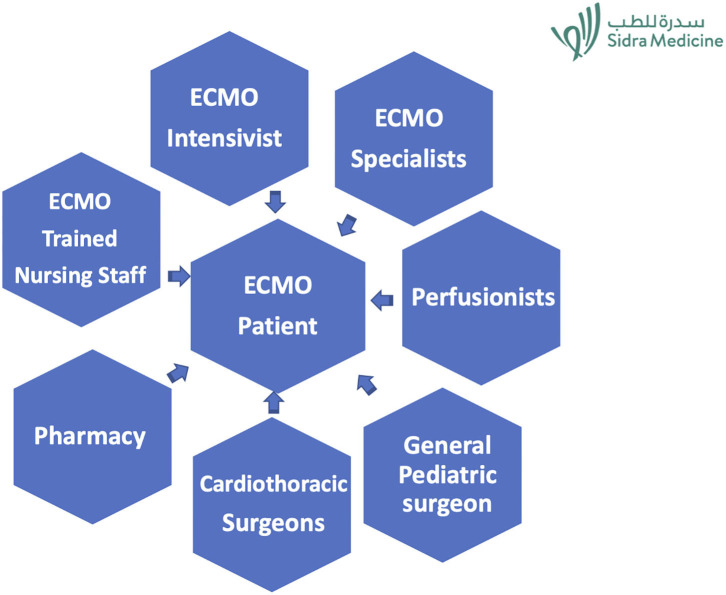
ECMO care model.